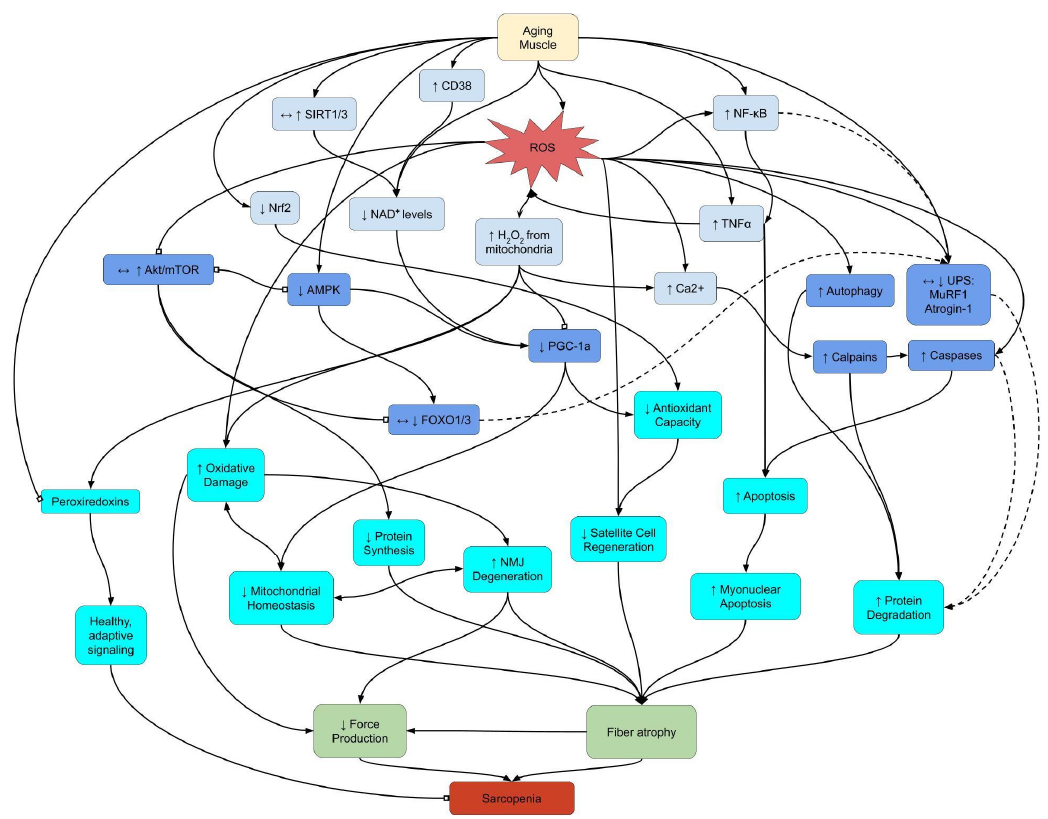
Figure 1. Select redox signaling pathways underlying sarcopenia. Lines between boxes indicate signaling pathway connections. Arrowheads represent an increase or promotion, while block heads represent inhibition. Dashed lines indicate pathways with a minor or negligible role in sarcopenia. Arrows within boxes show changes in sarcopenia based on upstream signals. Abbreviations: AMPK: 5 ′ adenosine monophosphate-activated protein kinase; Ca 2+ : calcium ions; CD38: cluster of differentiation 38; H 2 O 2 : hydrogen peroxide; mTOR: mechanistic target of rapamyacin; NAD + : nicotinamide adenine dinucleotide; NF- κ B: nuclear factor kappa-light-chain-enhancer of activated B cells; NMJ: neuromuscular junction; Nrf2: nuclear factor erythroid 2-related factor 2; PGC-1 α : peroxisome proliferator-activated receptor gamma coactivator 1-alpha; ROS: reactive oxygen species; SIRT: sirtuin; TNF α : tumor necrosis factor alpha; UPS: ubiquitin-proteosome system.